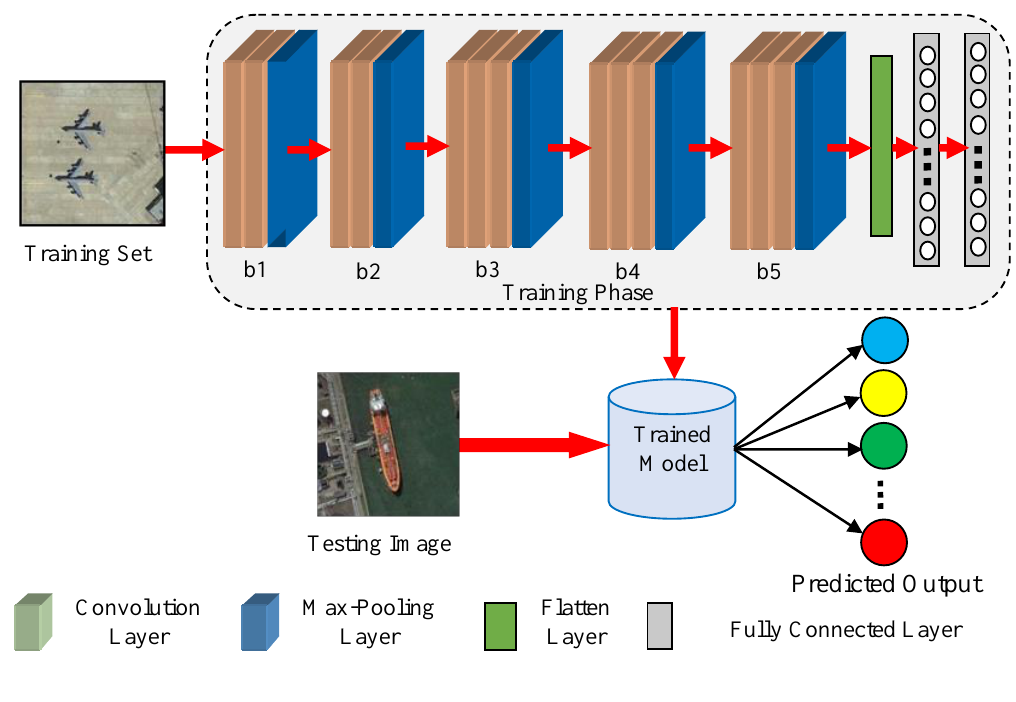
Figure 2. Proposed architecture of RSISC-16 Net